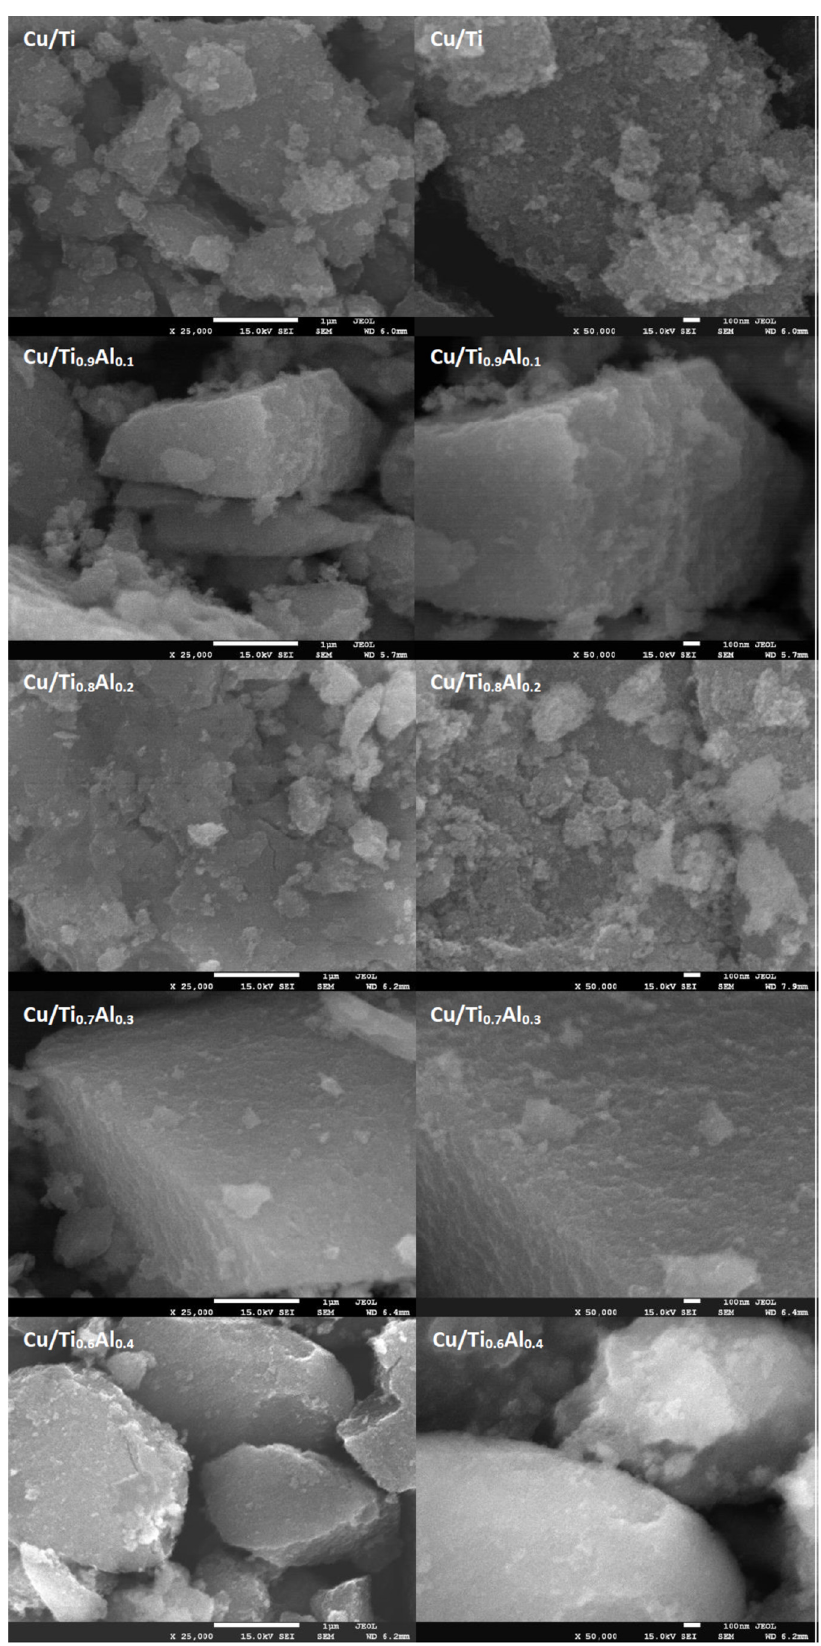
Figure 2. SEM images with the morphology of the Al-titania supported copper